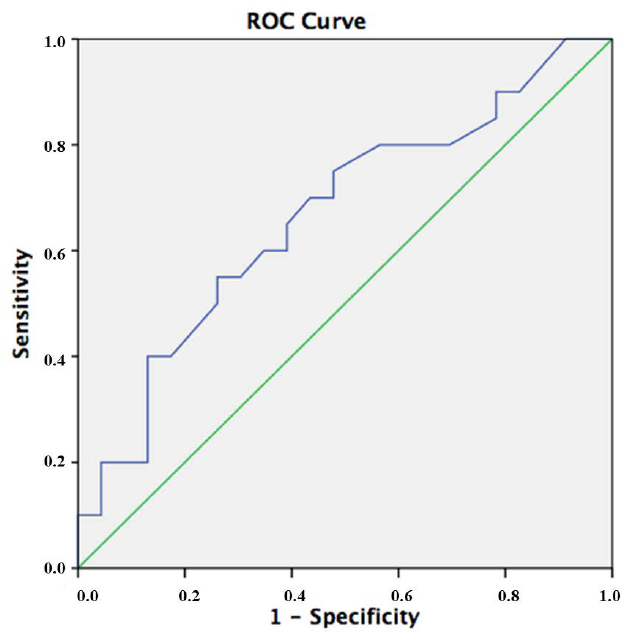
Figure 4. ROC (Receiver Operating Characteristic) curve analysis evaluating the sensitivity and specificity of lumbar bone mineral density (BMD) vs presence of fractures in SCD